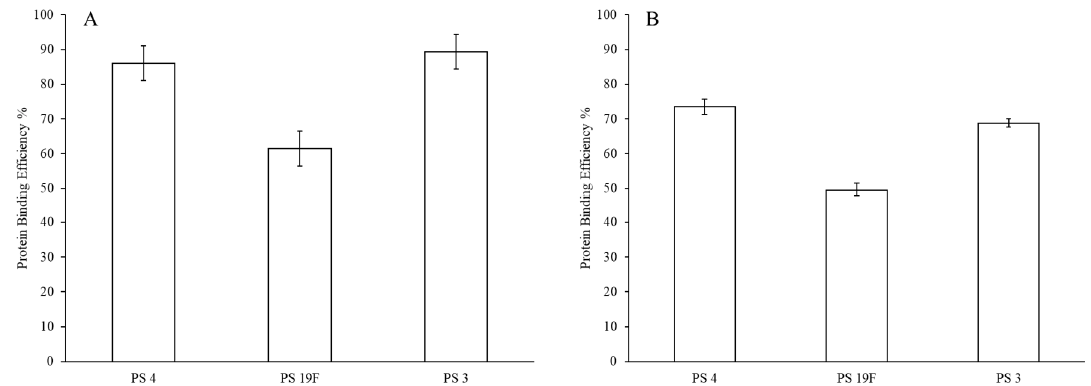
Figure 5. Green fluorescent protein (GFP) LEPS surface attachment efficiency without ( A ) and with ( B ) alum.